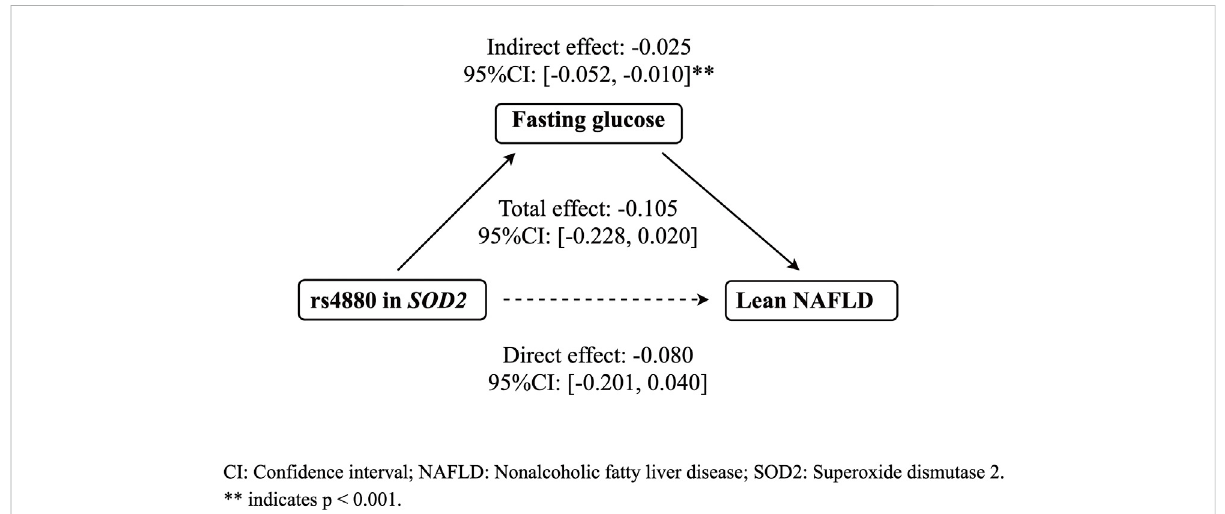
FIGURE 1 The mediation effect of fasting glucose on the association between rs4880 and the risk of lean NAFLD. CI: Con fi dence interval; Nonalcoholic fatty liver disease; SOD2: Superoxide dismutase